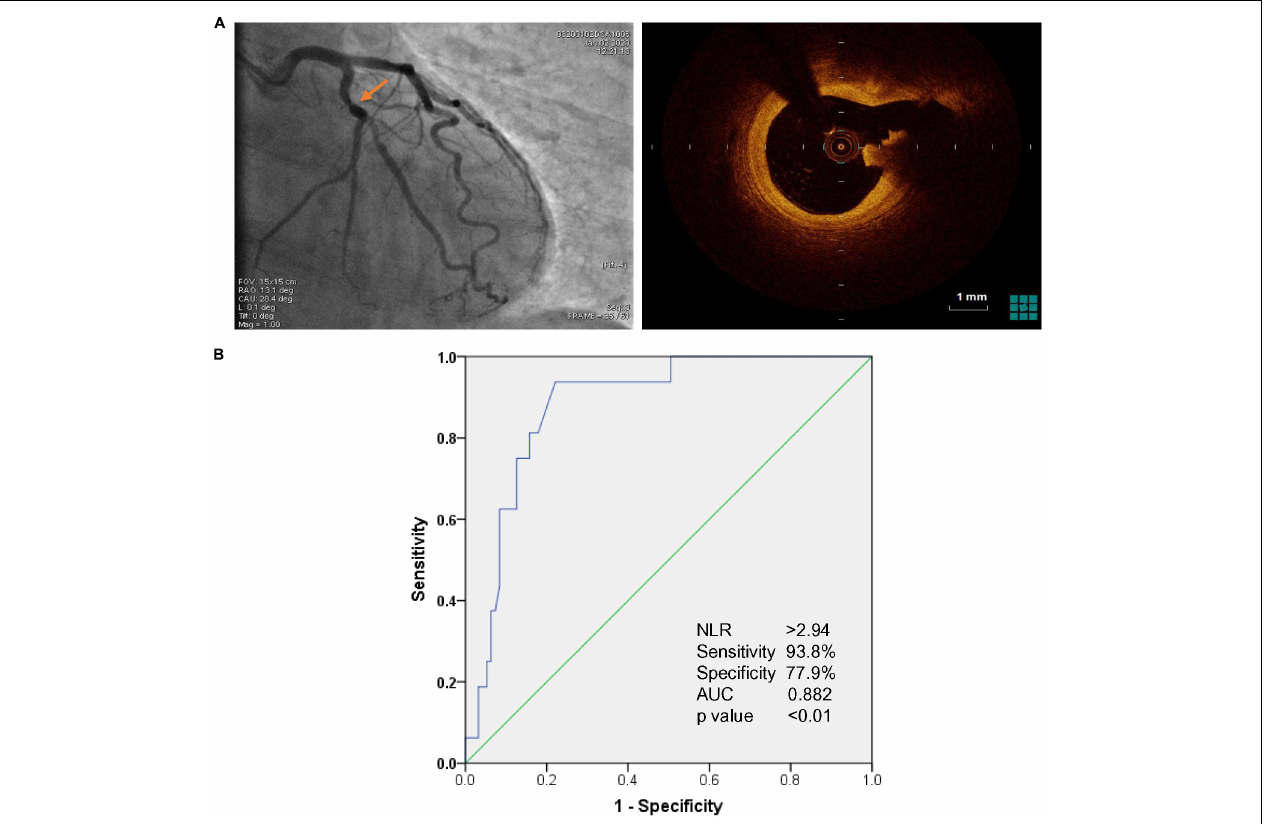
FIGURE 1 | (A) Representative image of optical coherence tomography (OCT)-identified plaque rupture (right panel) in angiographically intermediate coronary lesions (arrowhead in left panel). (B) Receiver Operating Characteristic (ROC) for evaluation of Neutrophil to lymphocyte ratio (NLR) associated with plaque rupture in acute coronary syndrome (ACS) patients with intermediate coronary artery lesions. The cutoff value of NLR associated with plaque rupture was NLR > 2.94 with 93.8% sensitivity and 77.9% specificity [Area Under Curve (AUC): 0.882, CI 95% 0.809–0.955, p <